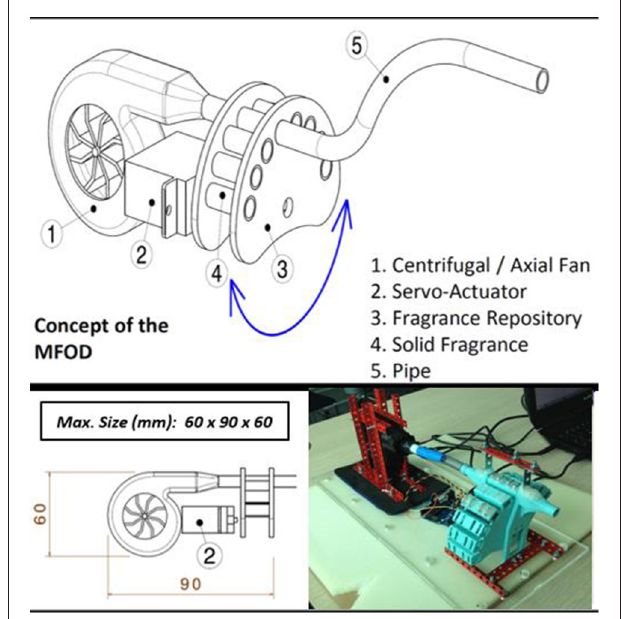
FIGURE 1 | The multi-fragrance olfactory